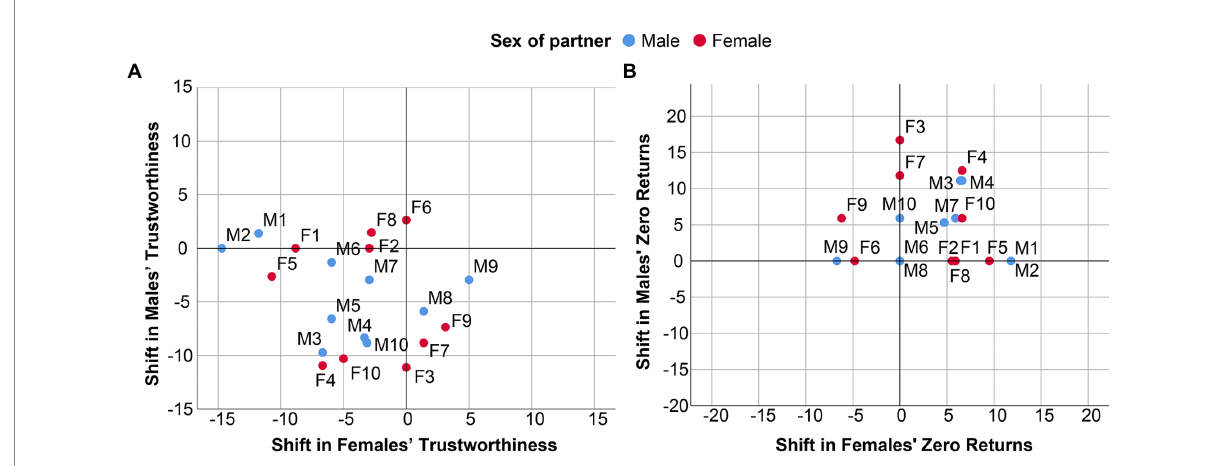
FIGURE 4 Shifts in trustworthiness elicited by the 20 videos of interaction partners. The graphs depict the average shift in trustworthiness in female (horizontal axis) and male (vertical axis) subjects elicited by each of the 20 videos of interaction partners (10 males: M1-M10 and 10 females: F1- F10). The two panels correspond to two different ways to quantify a shift in trustworthiness. (A) Average difference in returns in the personalized and the anonymous setting; (B) difference in the frequency of zero returns in the personalized and the anonymous setting. Notice that a positive value in (B) indicates a negative effect on trustworthiness.